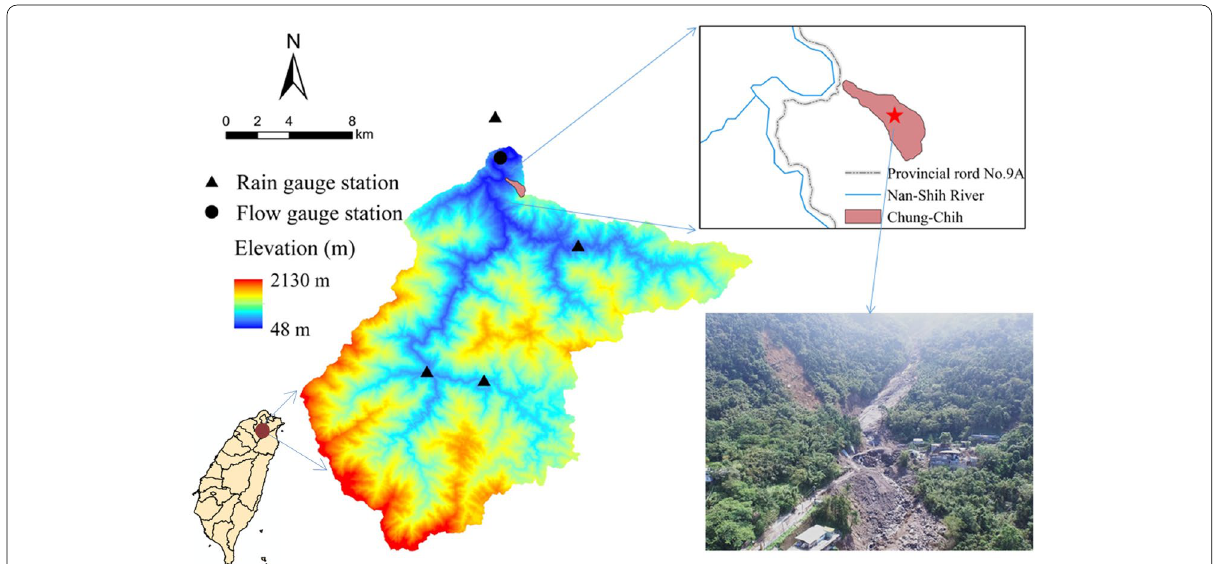
Fig. 2 Location map of Shang‑Gui‑Shan Bridge watershed and Chung‑Chih village catchment